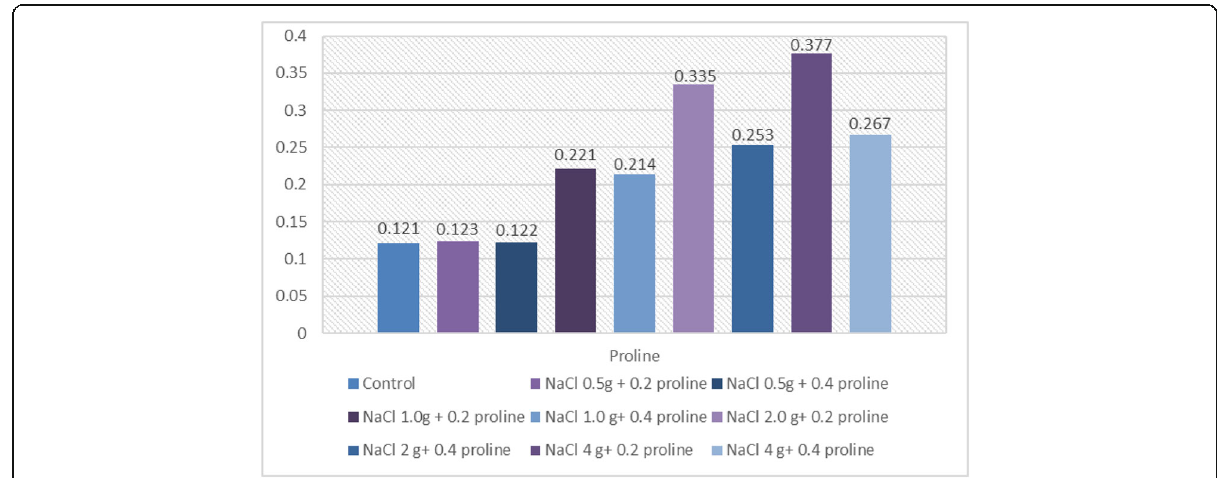
Fig. 5 Proline content (nmol/mg) in Paulownia shootlets effecting by different salinity levels and proline